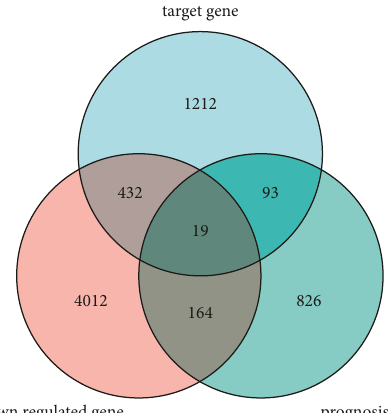
Figure 6: Venn diagram of common genes for miR-149-3p target genes, UCEC-downregulated genes, and prognosis-related genes.